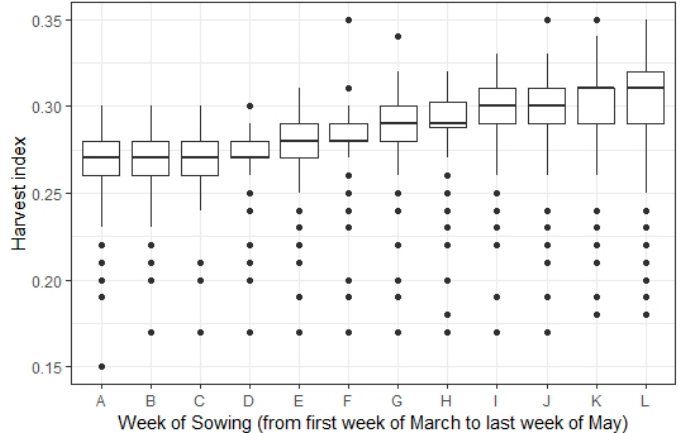
Figure 9. Box plot of the harvest index of a dual-purpose winter wheat sown at different times (from the first week of March to the last week of May). The box plots show the 25th, 50th, and 75th percentiles.